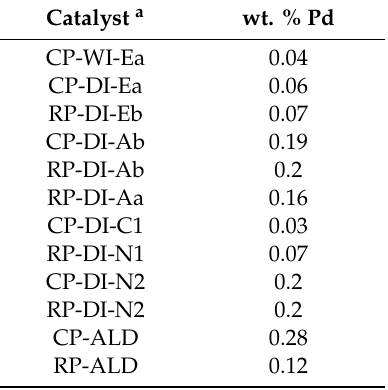
Table 1. Pd content of the catalysts by ICP analysis ( a see Table 3 for the catalyst name). Catalyst a wt. %